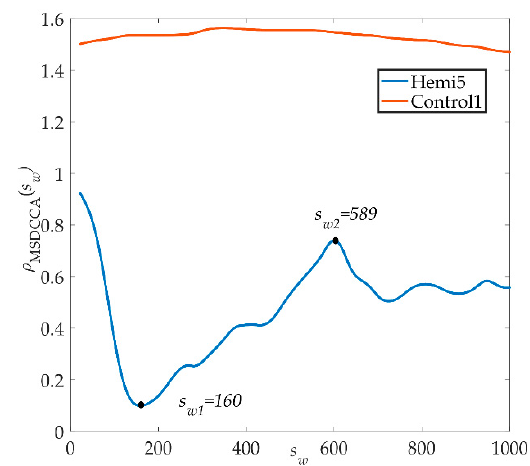
Figure 6. ρ MSDCCA spectrograms of healthy control 1 and hemiplegic patient 5.